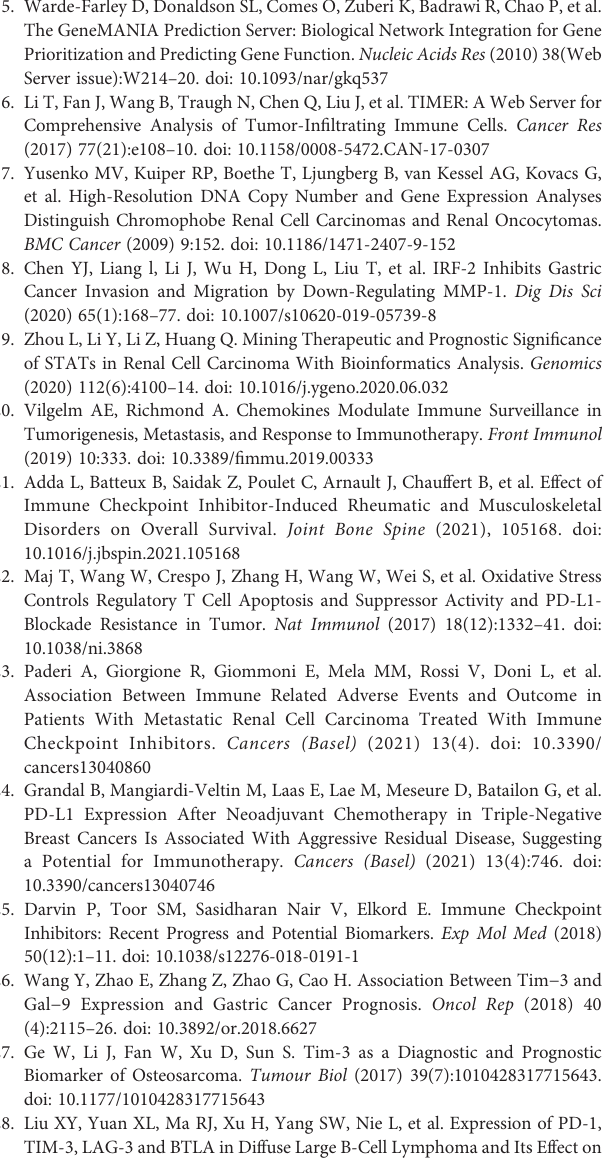
progression free curve of CD274 in KIRC patients with high and low CD274 expression, and the risk score, survival status and gene expression of each patients, as well as time-dependent ROC. Supplementary Figure 4 | The disease-free survival analysis of immune checkpoints in KIRC. (A) The disease-free survival curve of CTLA4 in KIRC patients with high and low CTLA4 expression, and the risk score, survival status and gene expression of each patients, as well as time-dependent ROC. (B) The disease-free survival curve of HAVCR2 in KIRC patients with high and low HAVCR2 expression, and the risk score, survival status and gene expression of each patients, as well as time-dependent ROC. (C) The disease-free survival curve of CD274 in KIRC patients with high and low CD274 expression, and the risk score, survival status and gene expression of each patients, as well as time-dependent ROC. (D) The disease-free survival curve of LAG3 in KIRC patients with high and low LAG3 expression, and the risk score, survival status and gene expression of each patients, as well as time-dependent